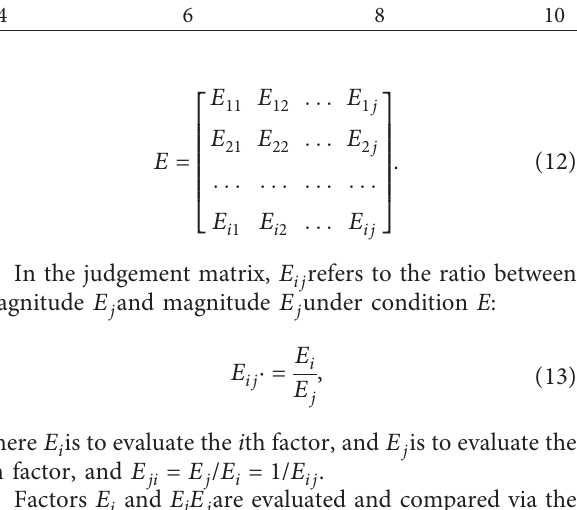
Table 7: The scores of maximum principal horizontal stresses. Major horizontal principal stress (MPa)